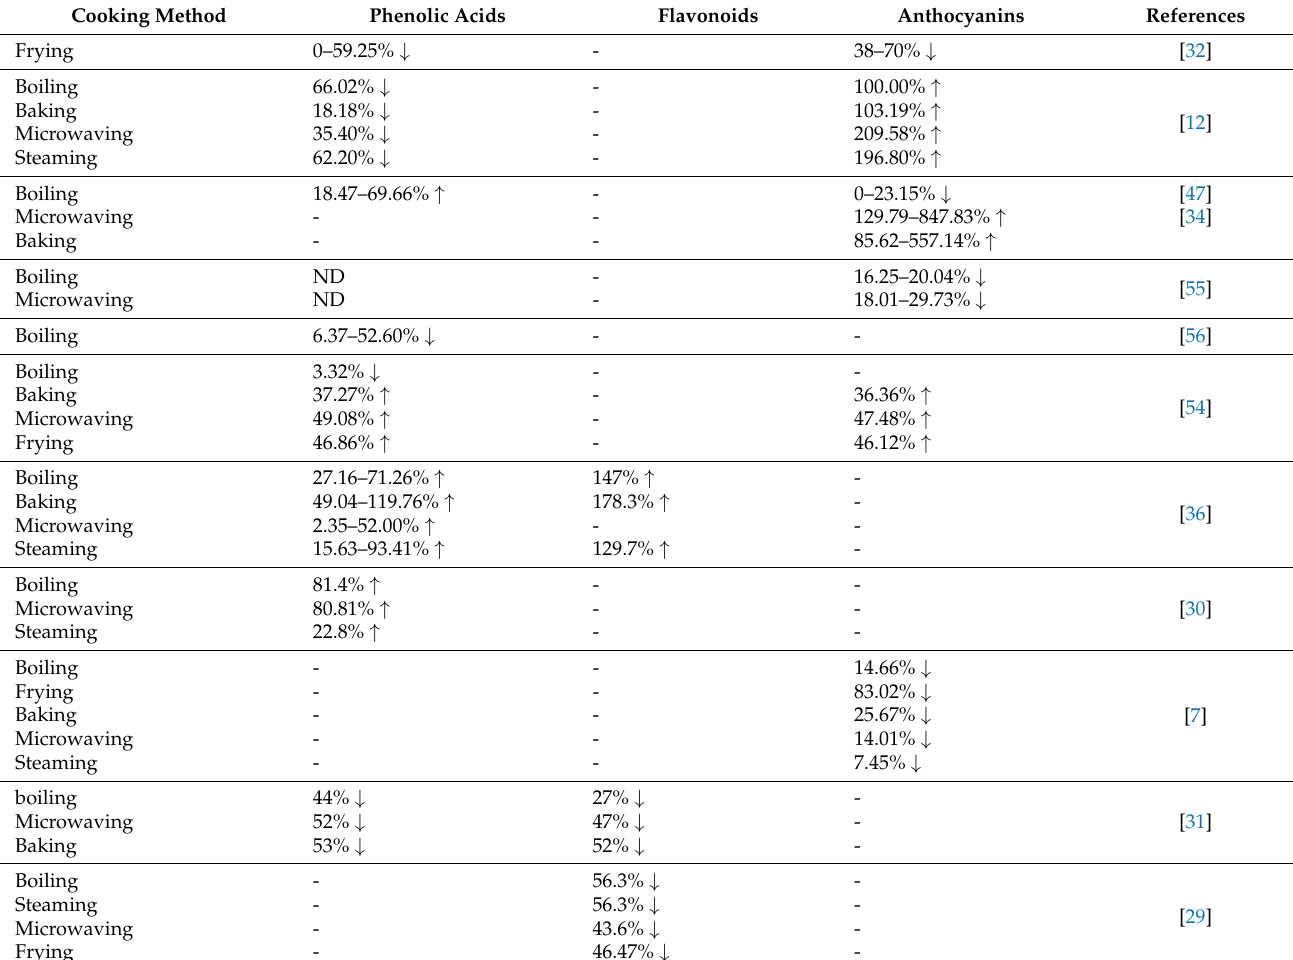
Table 2. Effect of cooking on the polyphenol content of